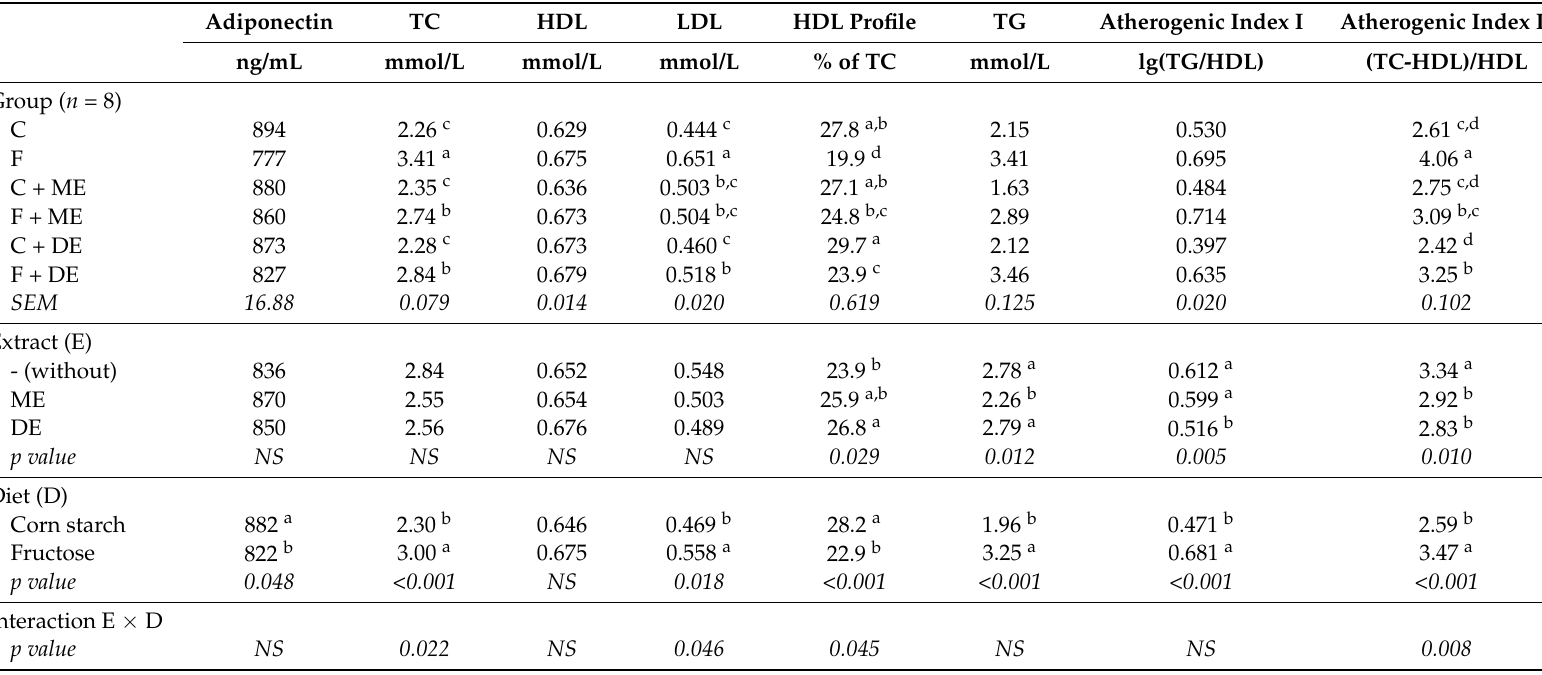
Table 8. Biochemical indicators in the blood serum lipid profile of rats fed experimental diets